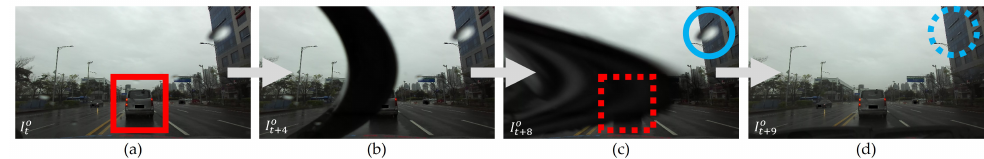
Figure 2. Problematic wiper effects in an experimental image sequence for time frames: ( a ) the frontal vehicle (solid red) is visible; ( b ) the wiper truncates the vehicle; ( c ) the wiper completely occludes the vehicle (dashed red) to wipe the adherent raindrop (solid blue); ( d ) the vehicle is back to visible, and the adherent raindrop is cleared (dashed blue). Best viewed with